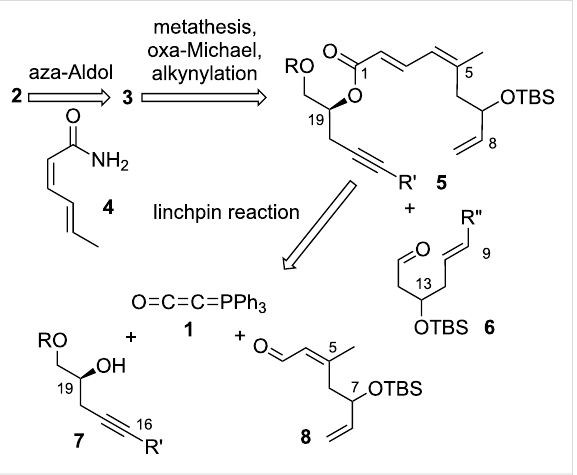
Figure 1: Structures of ( − )-zampanolide ( 2 ) and (+)-dactylolide ( 3 ).